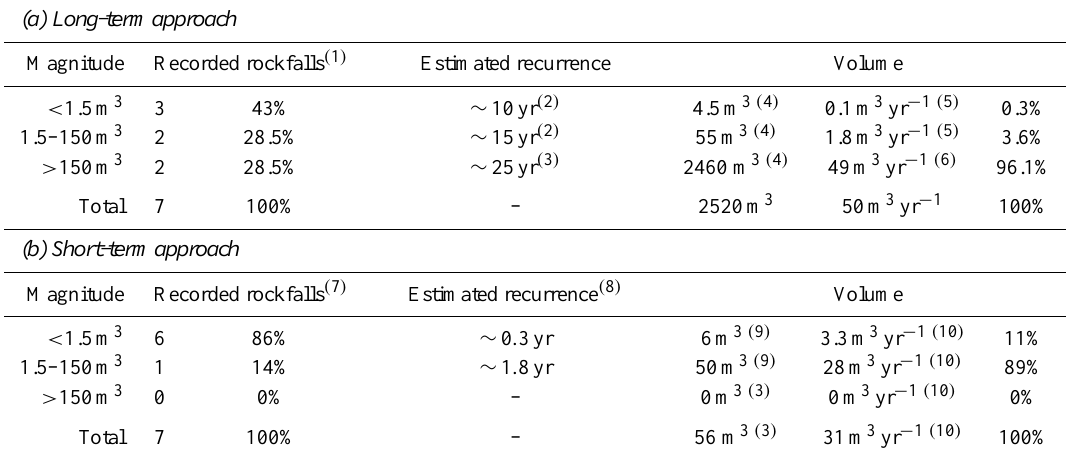
Table 3. (a) Long-term results based on historical record and population surveys. Time span: 50years prior to this study. (b) Short-term results based on a sequential comparison of TLS datasets. Time span: 22months.